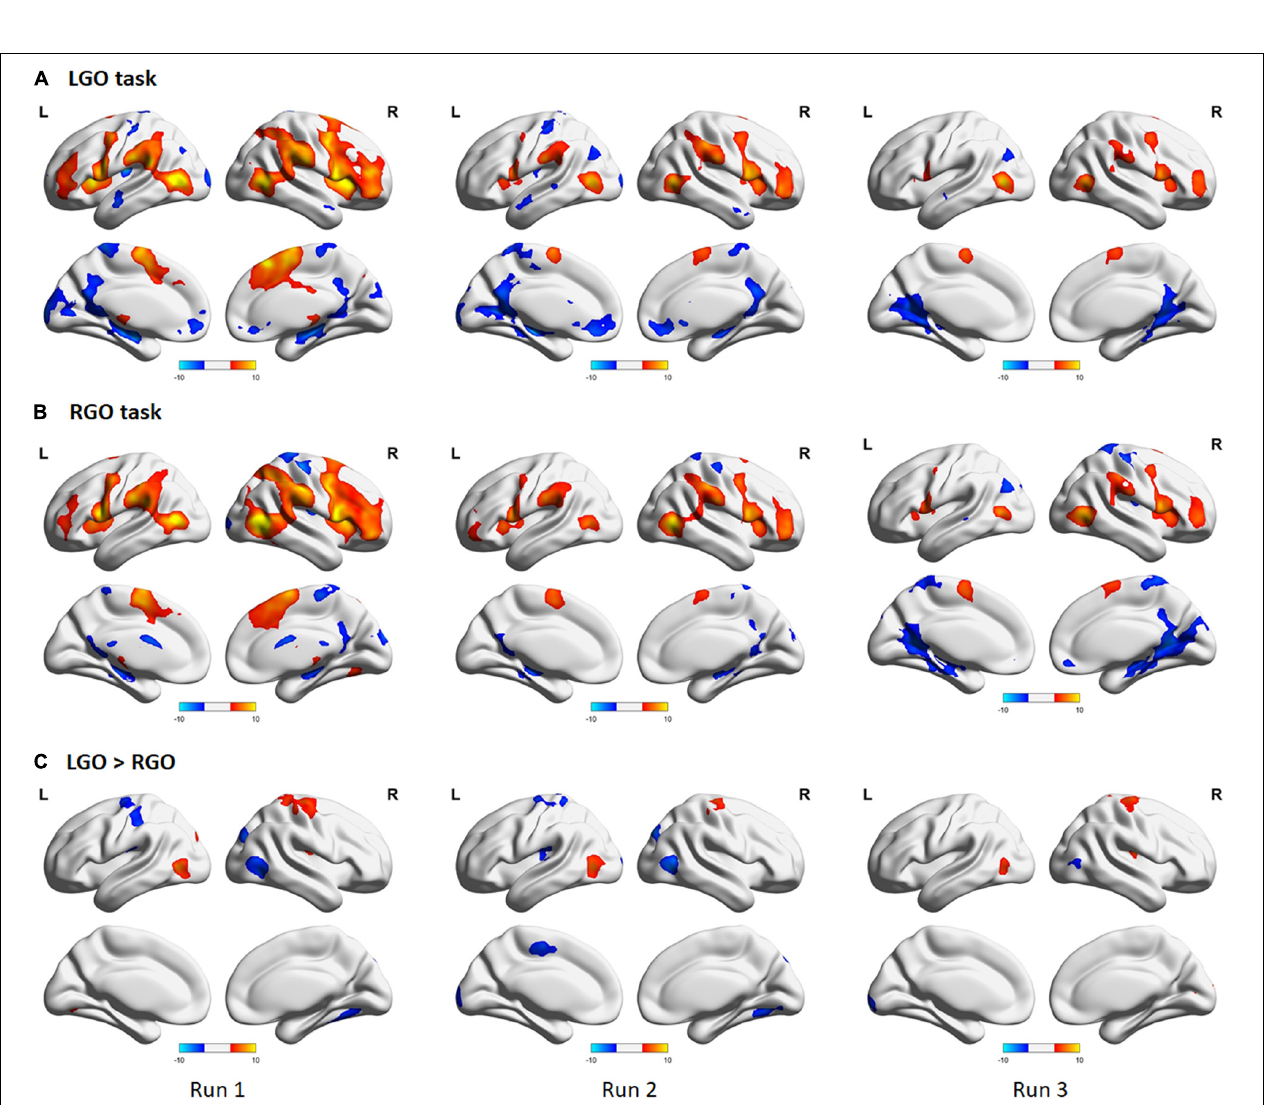
FIGURE 4 | Group activation maps for imagined (A) left hand gripping and opening (LGO) and (B) right hand gripping and opening (RGO) tasks and (C) the contrast (LGO > RGO) between the two tasks obtained using a one-sample t -test from individual contrast maps for feedback runs 1 to 3 (left to right). All statistical maps were corrected for multiple comparisons at the cluster level using family-wise error correction (FWEc) p < 0.05 with a cluster-defining threshold (CDT) set at p = 0.001.